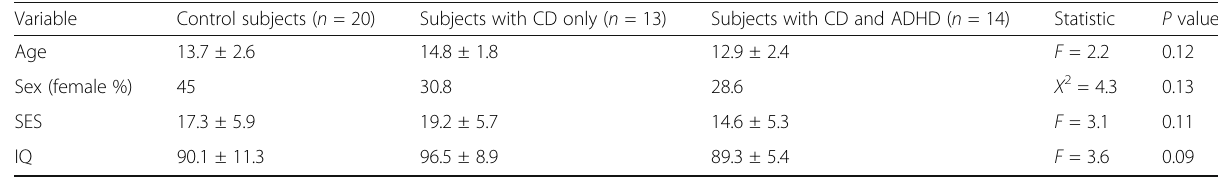
Table 1 Comparison between adolescents with conduct disorder with and without ADHD together with control adolescents regarding demographic data, socio-economic status, and IQ